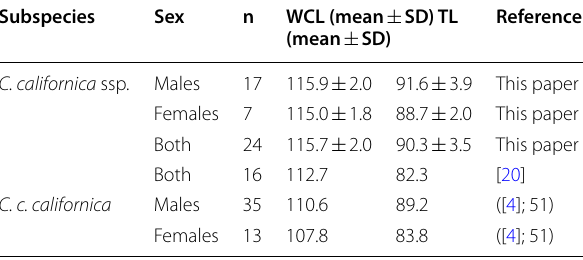
Table 2 Measurements (mm) of wing chord length (WCL) and tail length (TL) of California Quail Callipepla californica according to sex and origin for Metropolitan Region of Chile (unknown subspecies) and from California counties (USA) on C. c. californica Subspecies ±